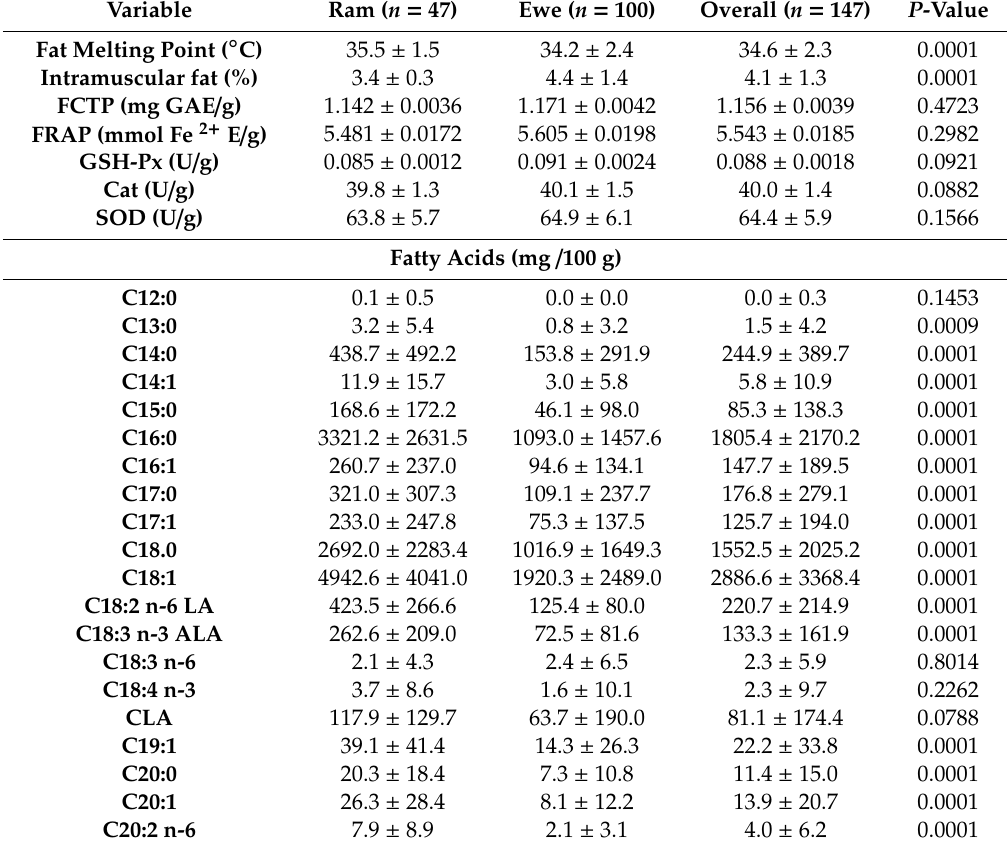
Table 3. E ff ect of gender (Means ± s.d.) on fat melting point, intramuscular fat, fatty acids, antioxidant phenolics and enzyme activities in the Longissimus dorsi muscle of ryegrass-fed Tattykeel Australian White (TAW) lambs 1